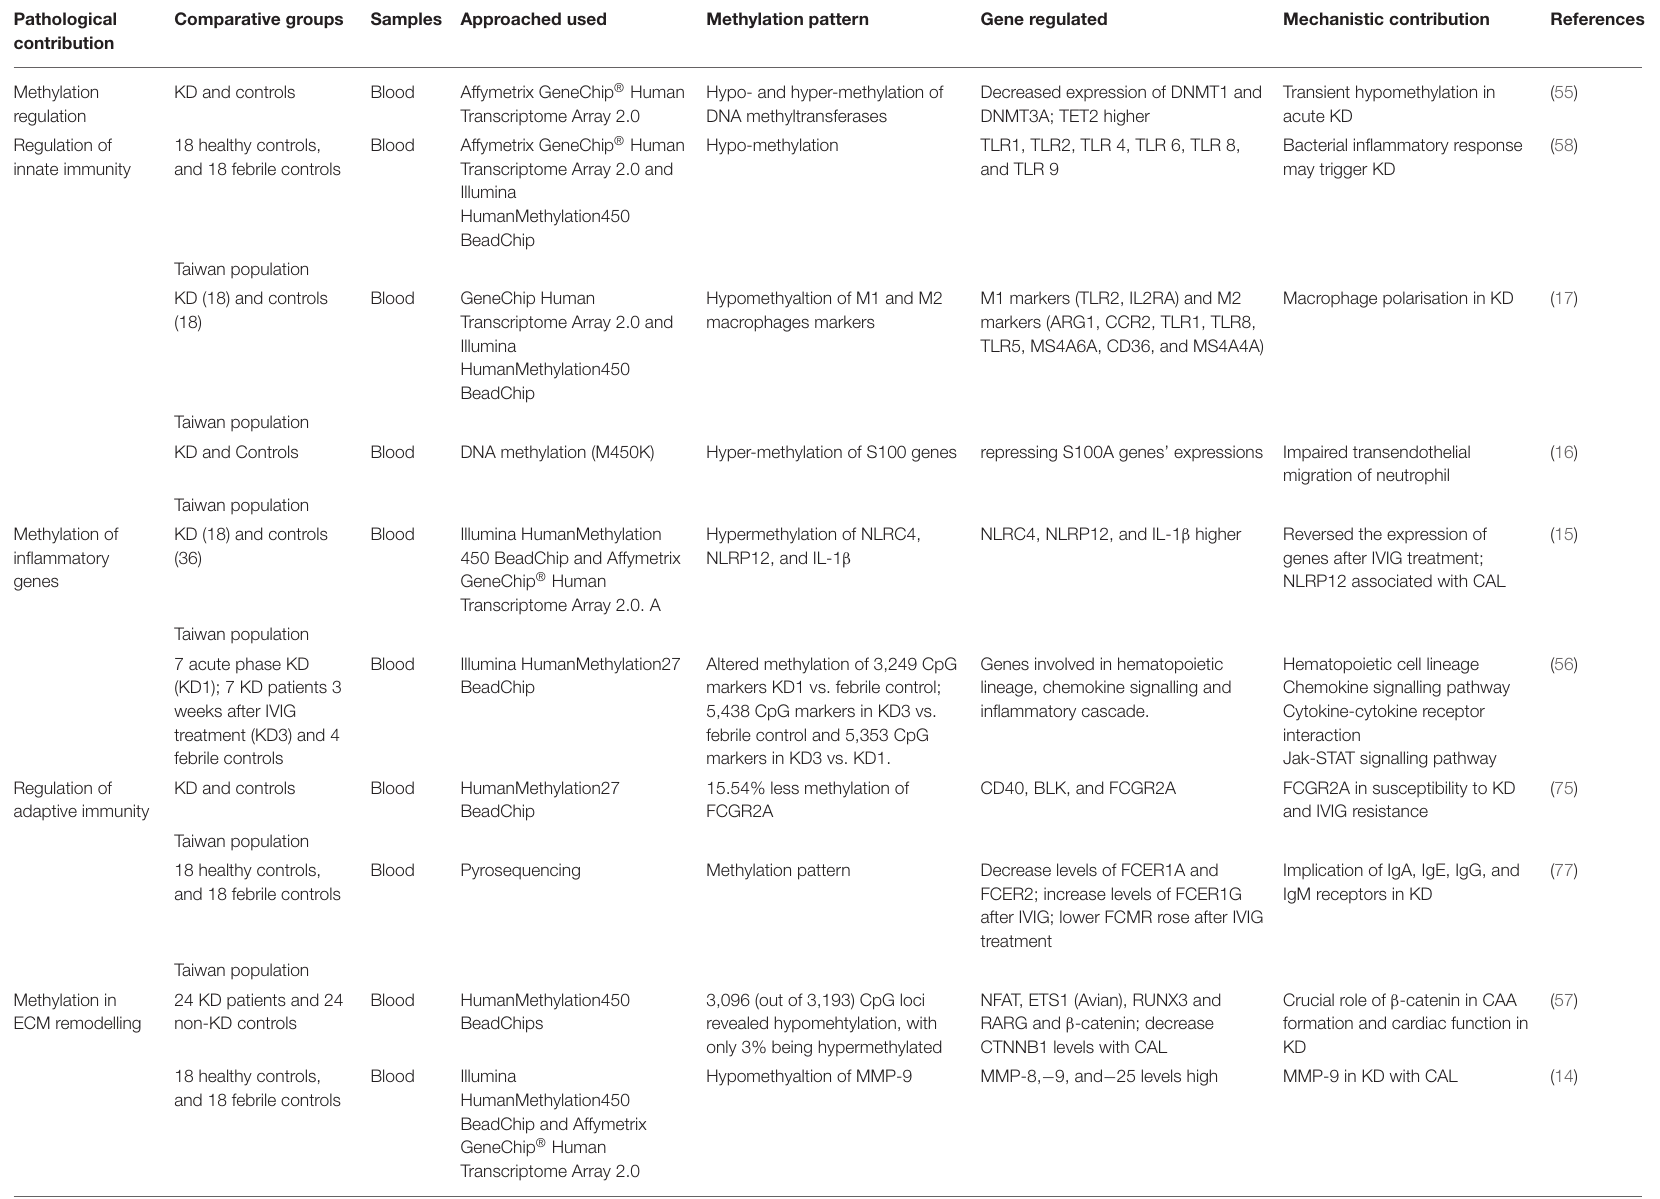
TABLE 1 | Tabular representation of studies related to regulation of genes by methylation, downstream cellular mechanism and implication in